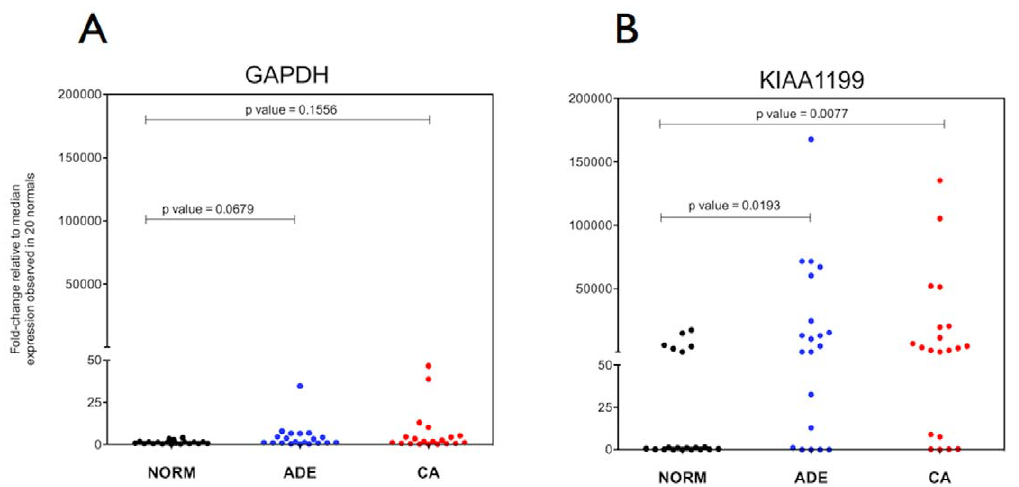
Figure 4. Measurement of RNA levels in plasma specimens. ( A ) GAPDH and ( B ) KIAA1199 RNA levels in plasma from 20 healthy subjects (black) and from 20 patients with colon adenomas (blue) and 20 CRC patients (red). Data are mean Ct values (triplicates) normalized for extraction yield differences and depicted as fold-change differences relative to the median expression measured in the 20 normal subjects. P values were calculated using two-tailed Mann-Whitney t-test.